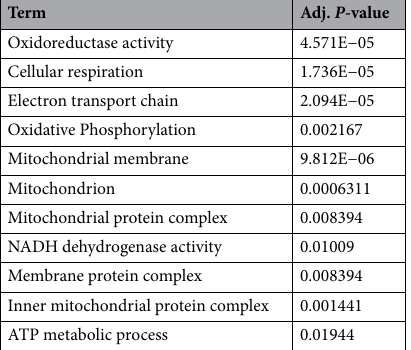
Table 6. Enriched GO functions in skeletal muscle from heifers divergent for